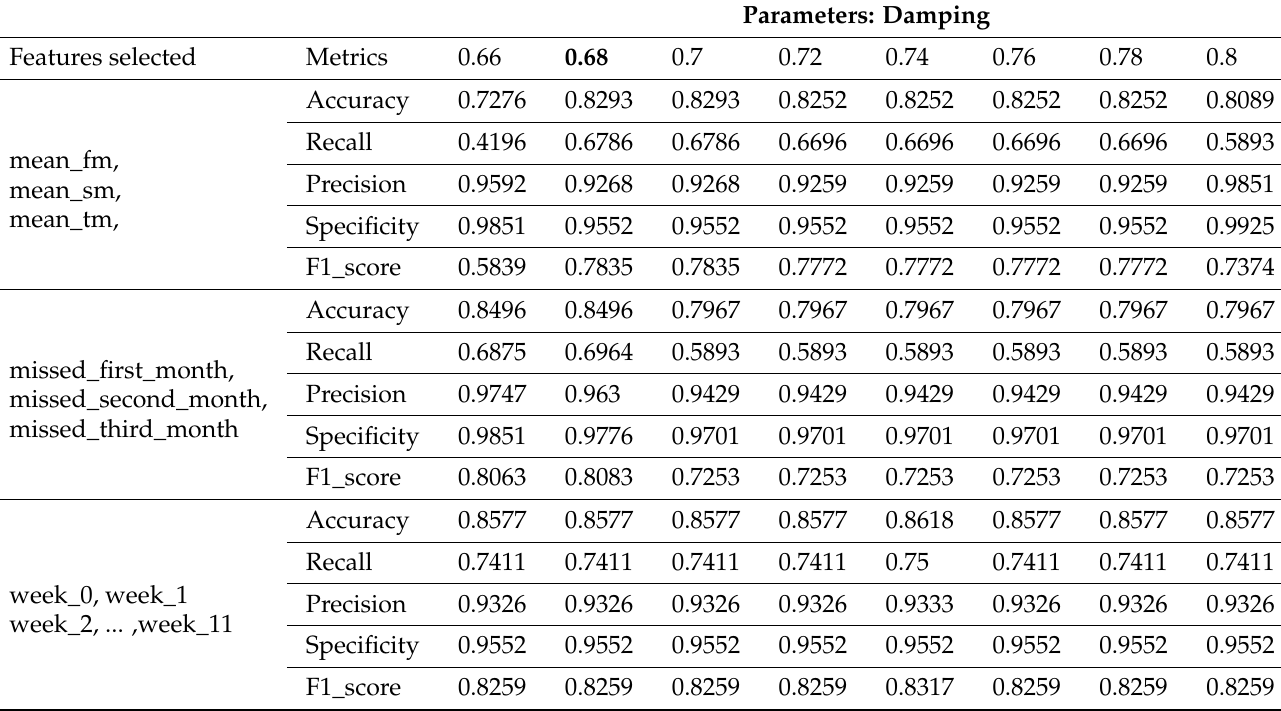
Table 19. Metrics, applying different configurations for Affinity propagation clustering—LSTM. Parameters: